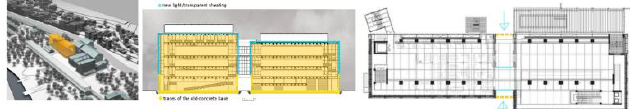
Figure 6. SabtrIstanbul and the place of contemporary art museum.